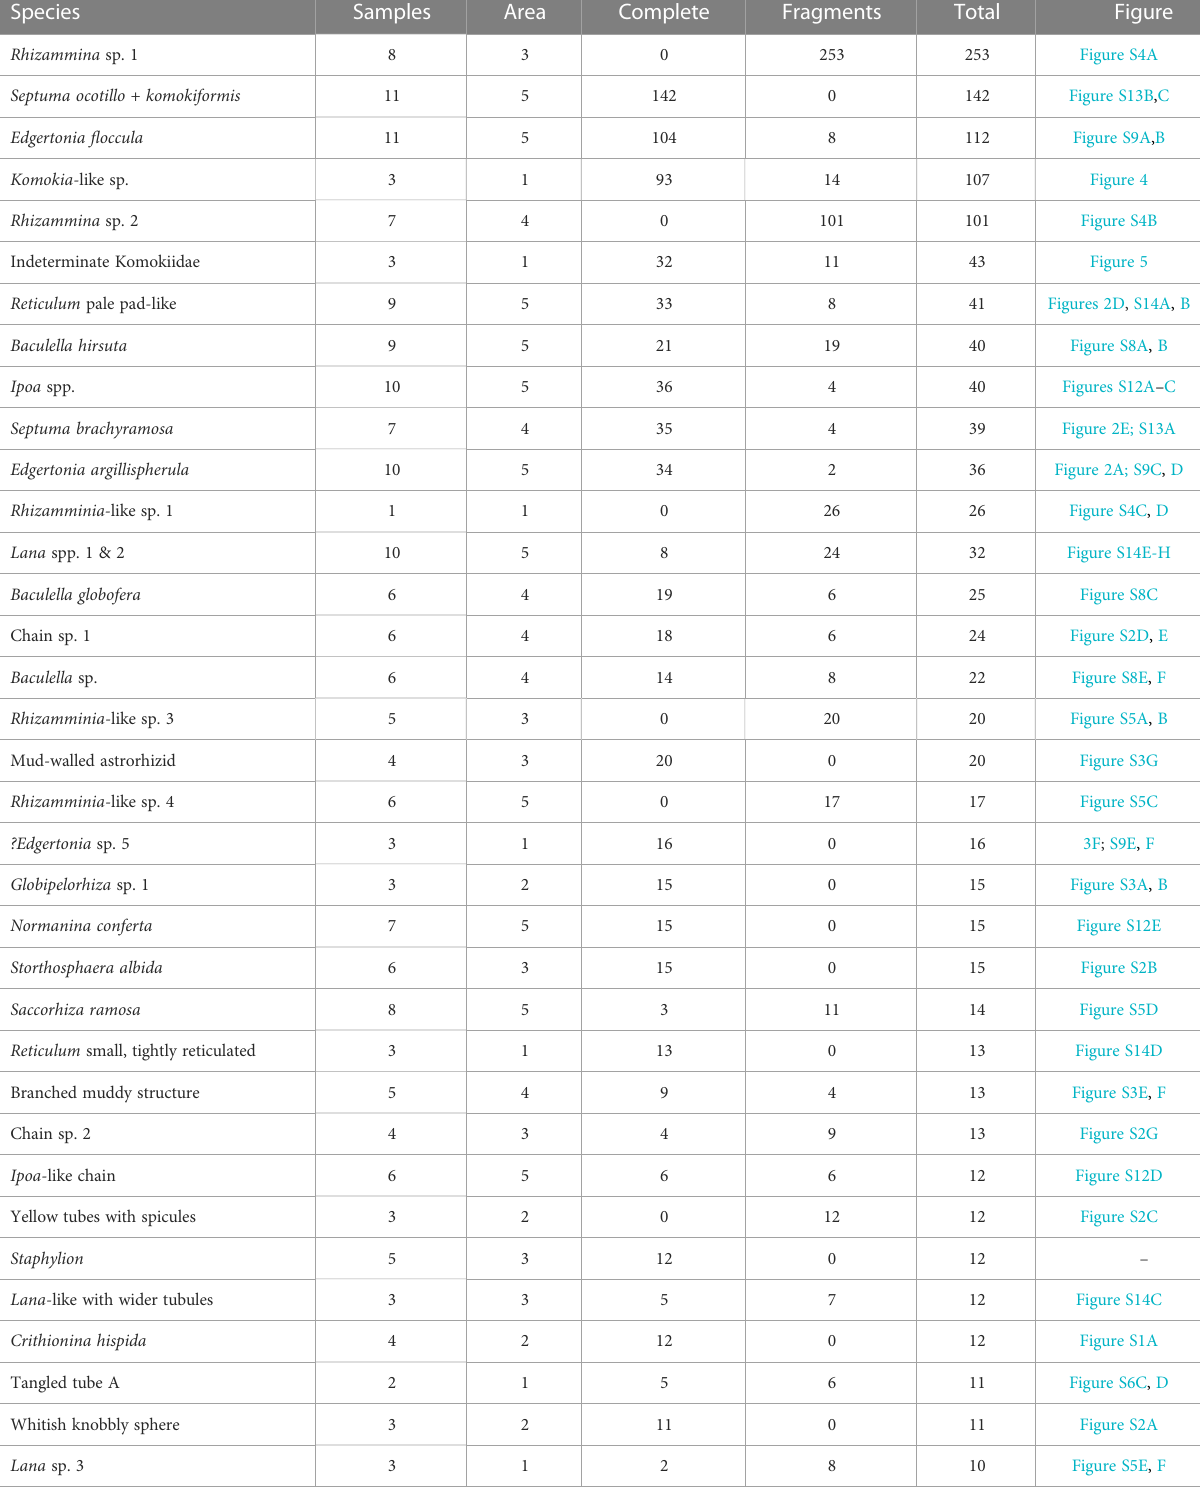
TABLE 5 Distribution in samples and areas of 35 top-ranked species represented by 10 or more complete or fragmentary specimens. Species Samples Area Complete